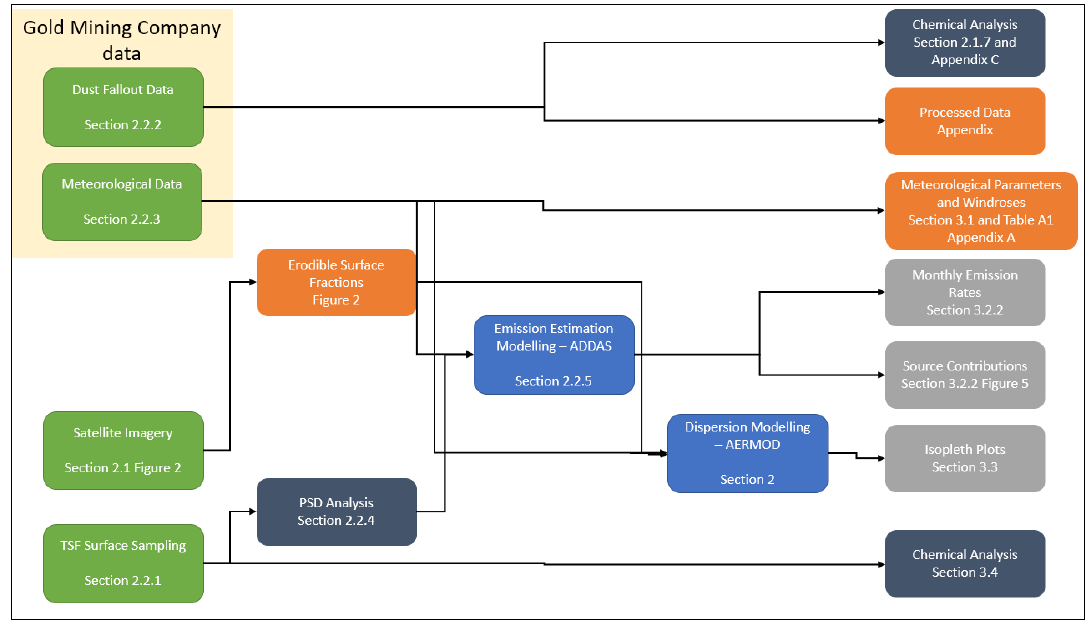
Figure 3. Process flow of the study methods.